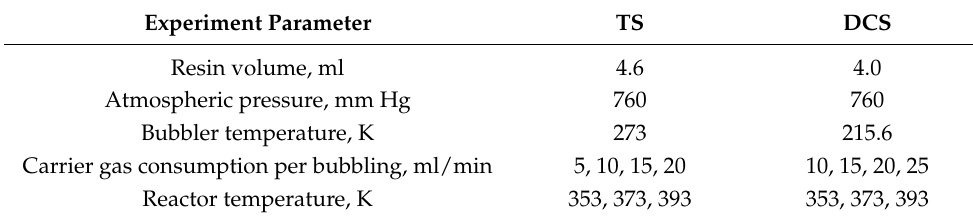
Table 2. Details of the design of kinetic experiments with TS and